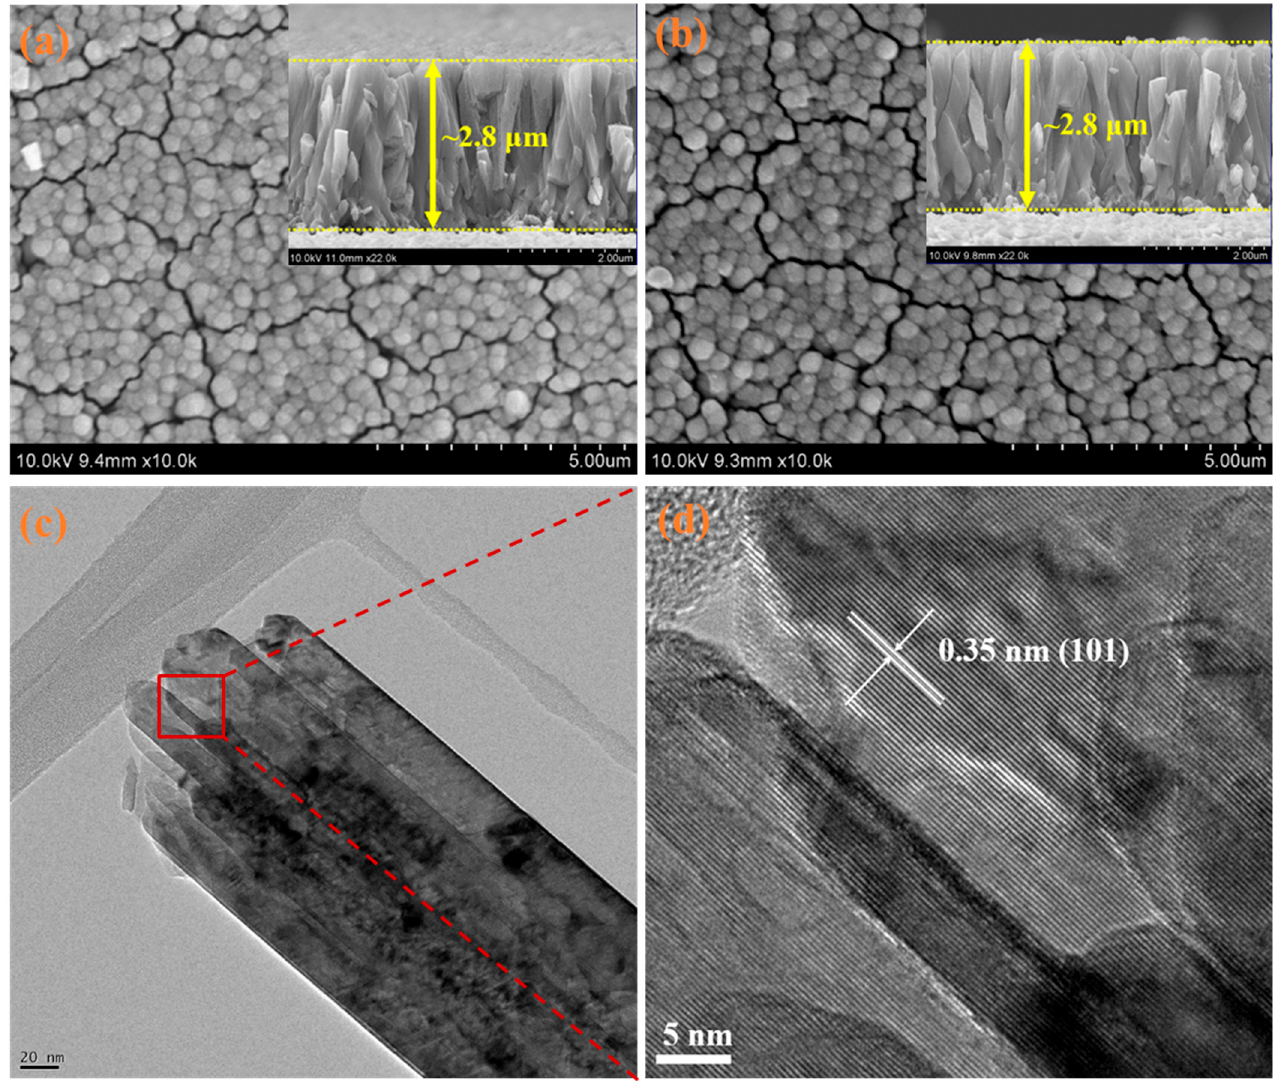
Figure 1. ( a , b ) Typical SEM of TiO 2 , TiO 2 @NCD4h. The corresponding cross-sectional SEM images are shown in the insets. ( c ) FETEM images of TiO 2 . ( d ) FETEM images of TiO 2 @NCD4h.